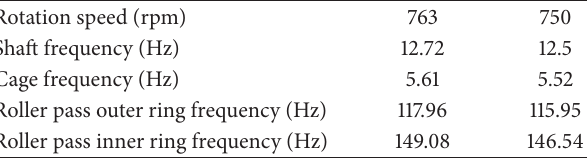
Table 6: Characteristic frequencies of SRB.